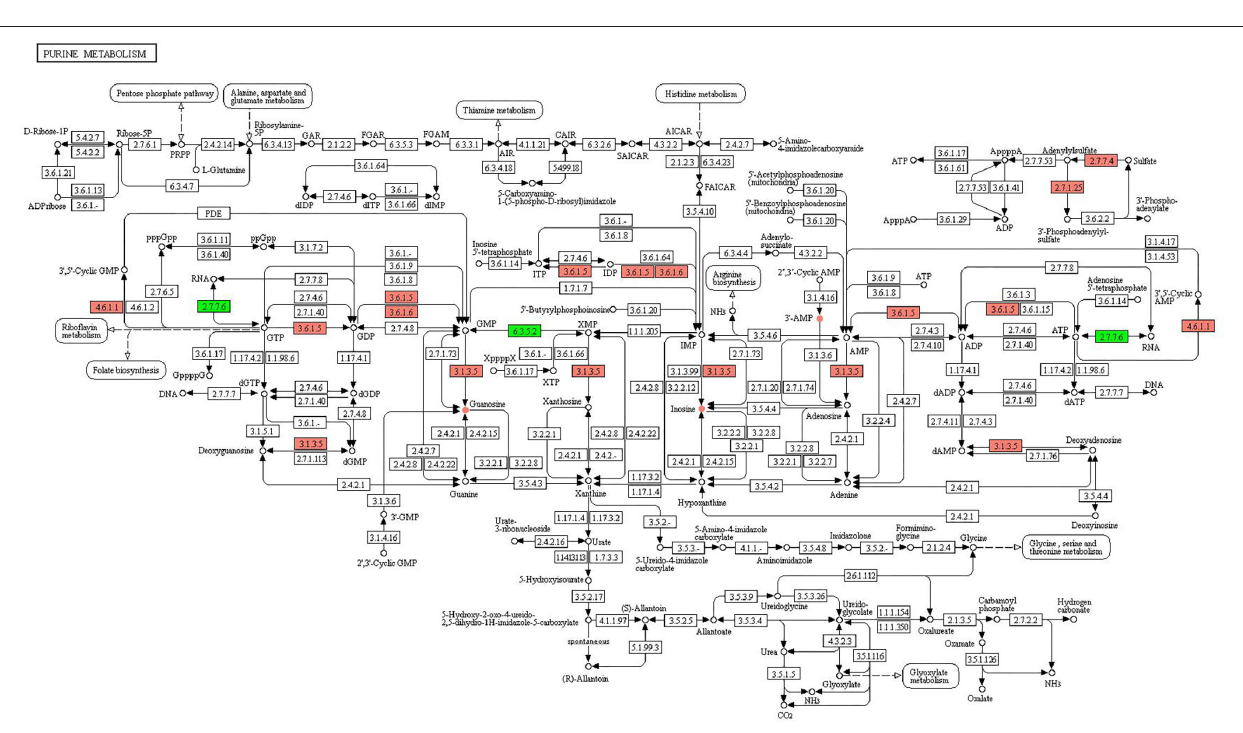
the most altered metabolites and DEGs ( Figures 7 , 8 , Supplementary Figures S8 – S15